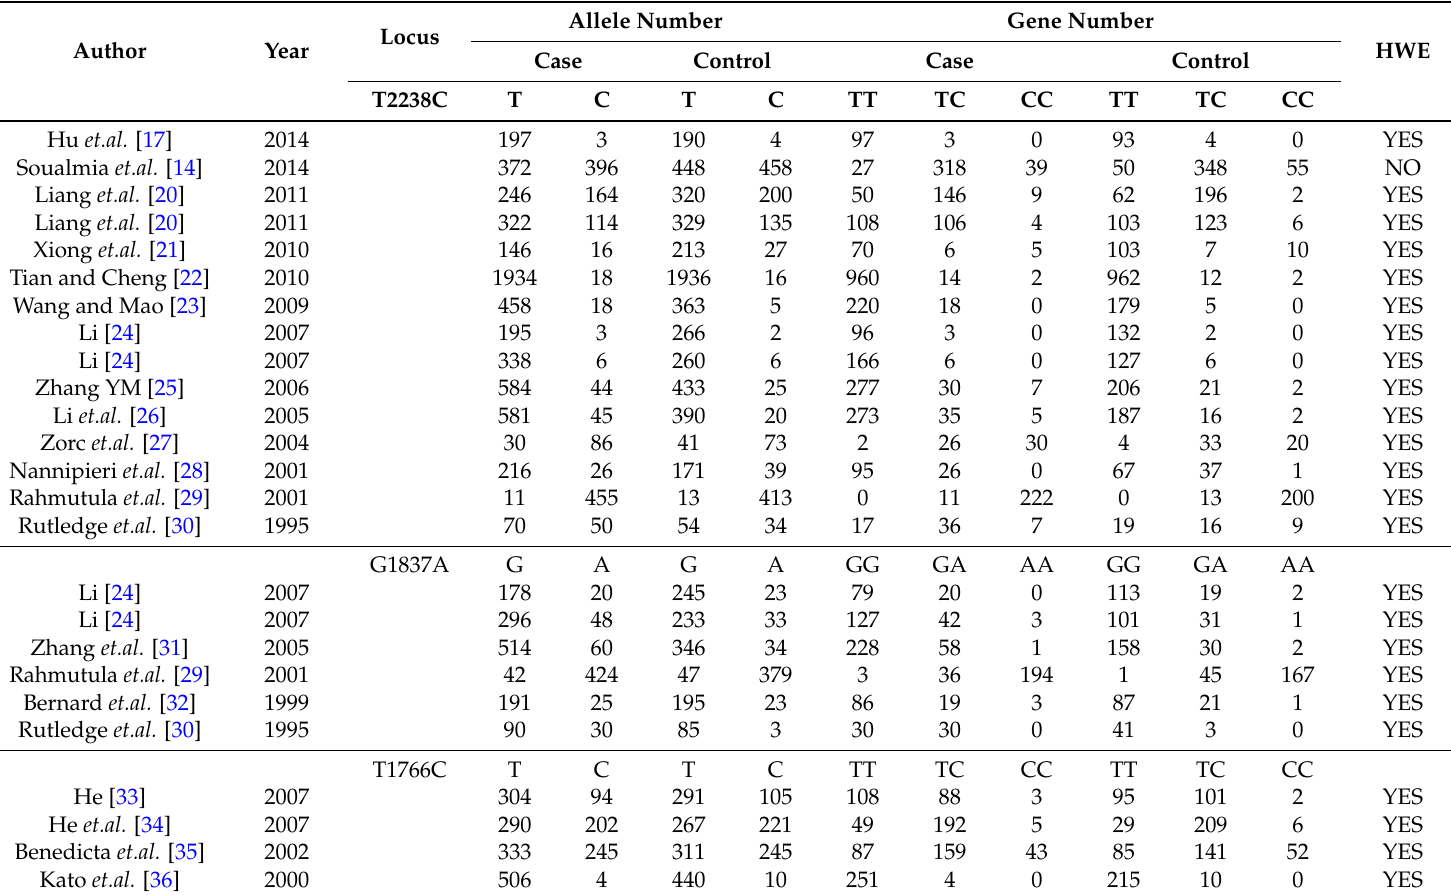
Table 2. The allele gene and genotype frequency of ANP polymorphisms in the